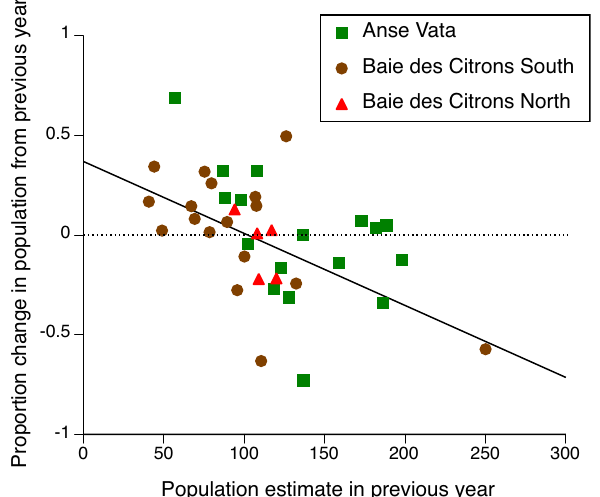
Figure 2. Univariate plot of density-dependence in annual changes in population densities of turtle-headed sea snakes, Emydocephalus annulatus, in three populations. Higher population densities were followed by reductions in population density the following year. Dotted horizontal line shows stability (no change in population density from one year to the next), and solid sloping line shows least-squares regression fitted to the combined dataset. See Table 1 for statistical tests of these data, incorporating weather